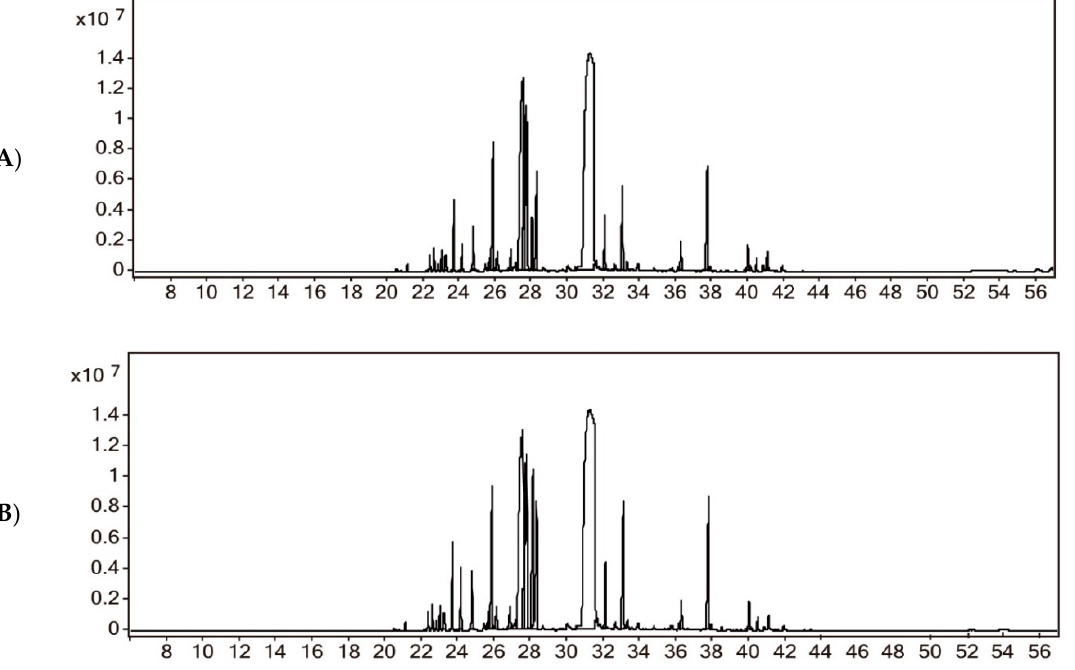
Figure 2. GC / MS chromatograms of the EOs of A. macrocephala. ( A ) GC / MS chromatograms of Figure 2. GC/MS chromatograms of the EOs of A. macrocephala. ( A ) GC/MS chromatograms of the EOs the EOs of crude A. macrocephala (CA); ( B ) GC / MS chromatograms of the EOs of bran-processed of crude A. macrocephala (CA); ( B ) GC/MS chromatograms of the EOs of bran-processed A. A. macrocephala macrocephala (BA).